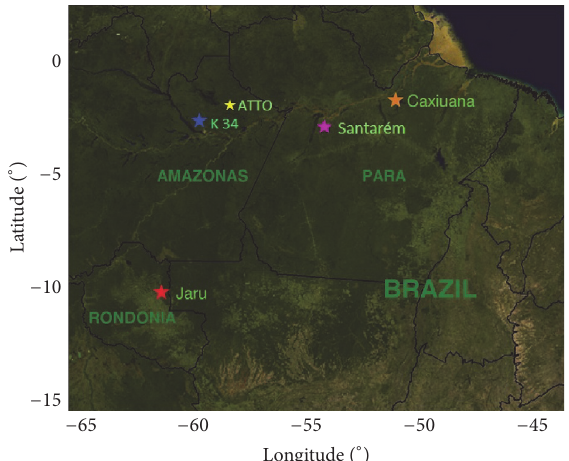
Figure1:ExperimentalsiteslocatedintheAmazon(source:adapted from Zeri et al. [26]).